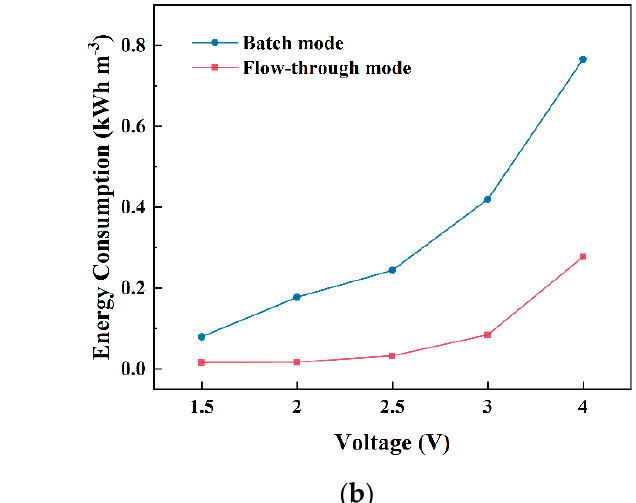
11 of 17 Figure 7. 8-h continuous operation performance. Experimental condition: voltage = 2 V, natural pH = 6.1, [Na 2 SO 4 ] = 0.1 mol L − 1 , [TC] = 10 ppm. 3.4. Comparison of Efficacy and Energy Consumption between Flow-Through and Batch Mode The efficacies in flow-through and batch mode were compared via kinetics analysis,